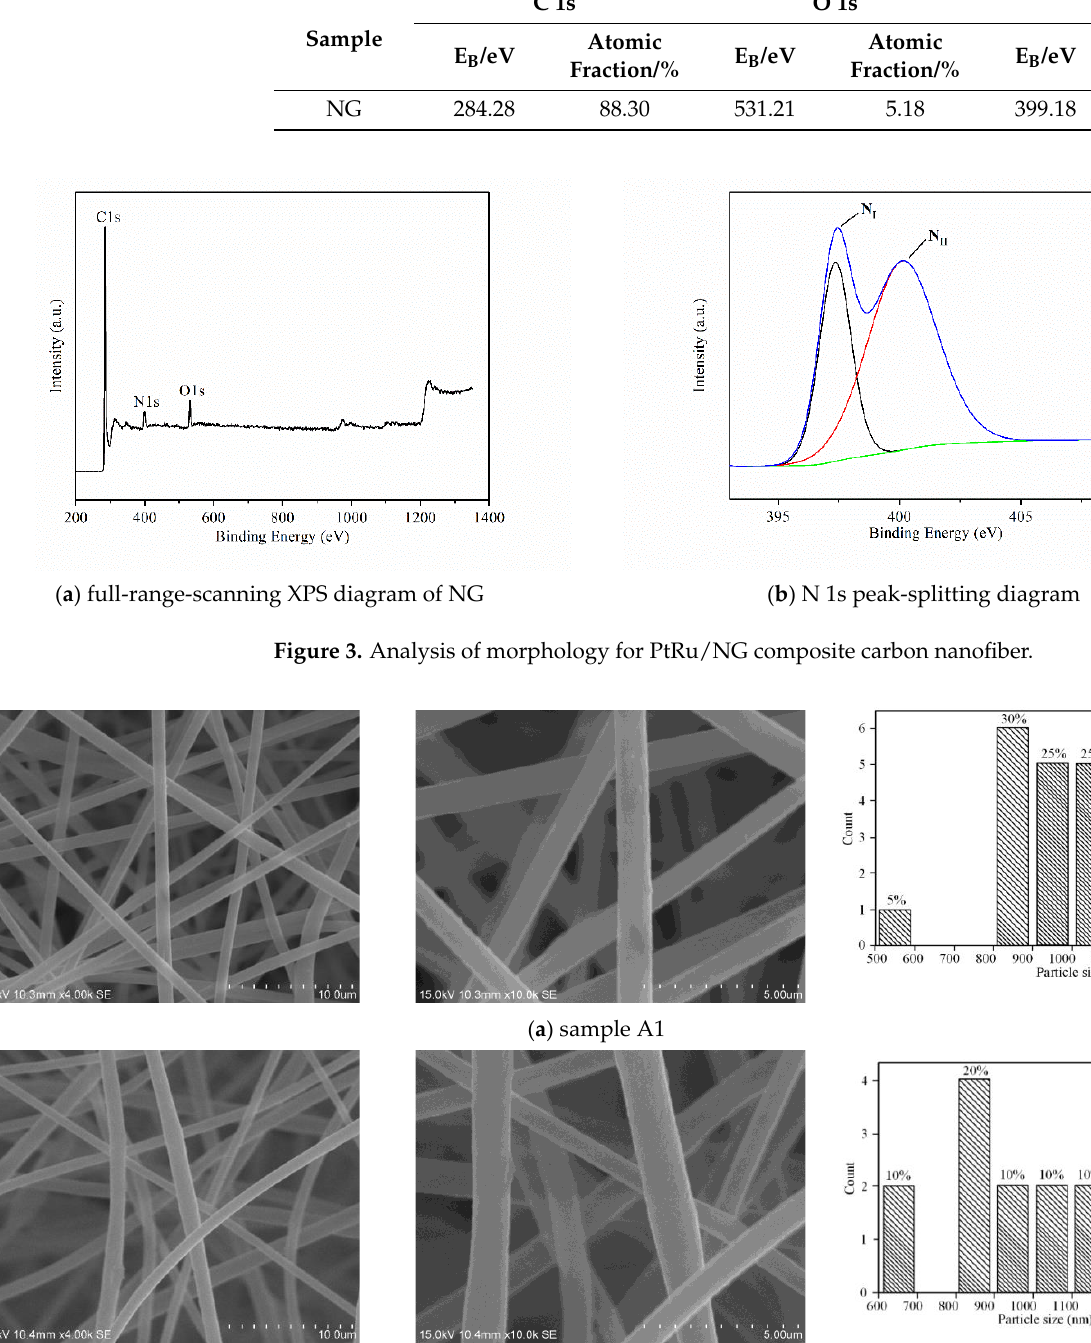
Table 1. Quantitative analysis results of NG.